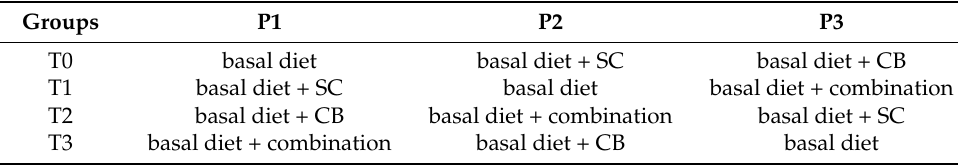
Table 2. 4 × 3 incomplete Latin-Square design of the